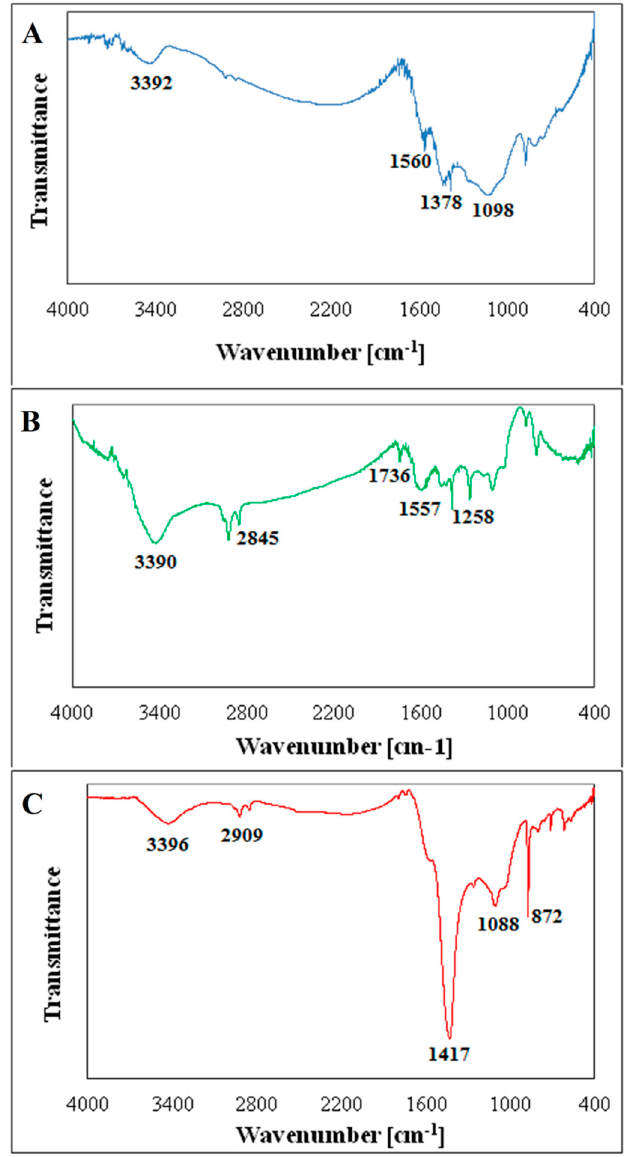
Figure 2. FTIR spectra of biochars: ( A ) vineyard (BV); ( B ) paulownia tree (BP), and ( C ) tobacco (BT).